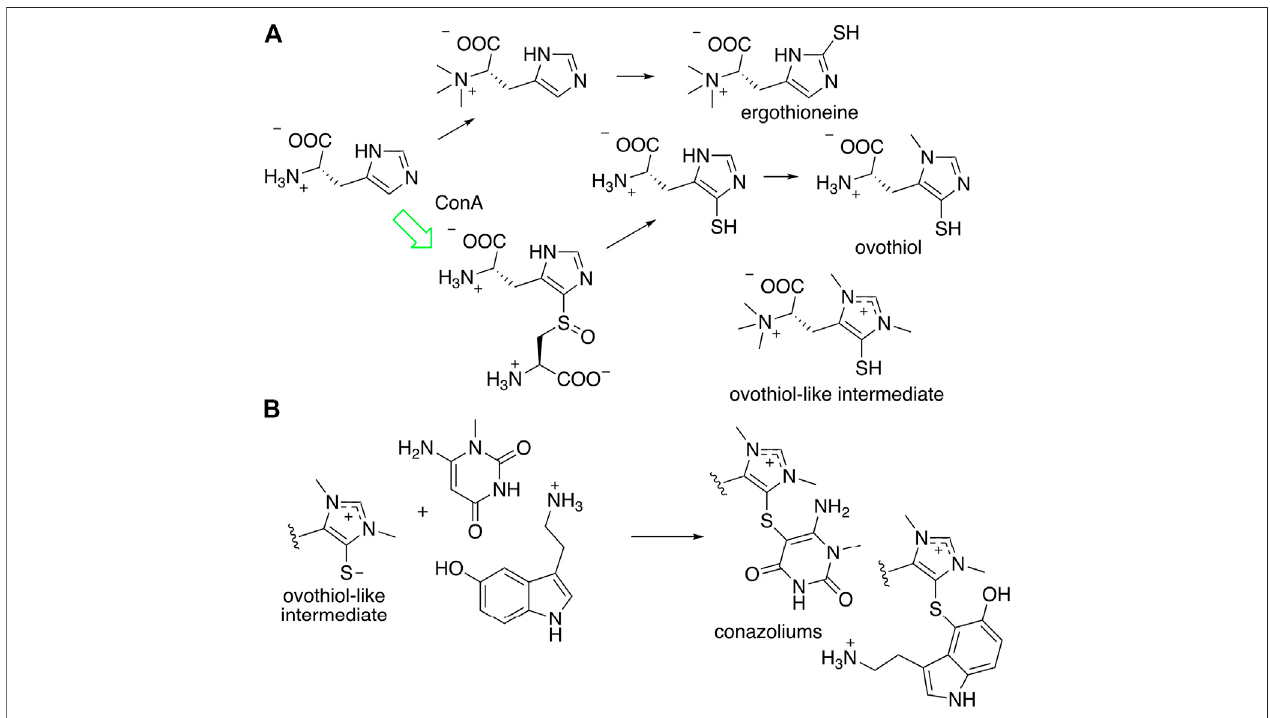
FIGURE 7 | Proposed biosynthesis of conazolium. (A) Known routes to antioxidants ergothioneine and ovothiol. The synthesis of an “ ovothiol-like intermediate ” that is the precursor to conazoliums has features of both pathways, but with an additional methylation on the imidazole ring. The arrow in green indicates a reaction that was characterized using the C. imperialis enzyme, ConA. (B) The “ ovothiol-like intermediate ” reacts with electrophilic metabolites to create the conazoliums ( 10 – 11